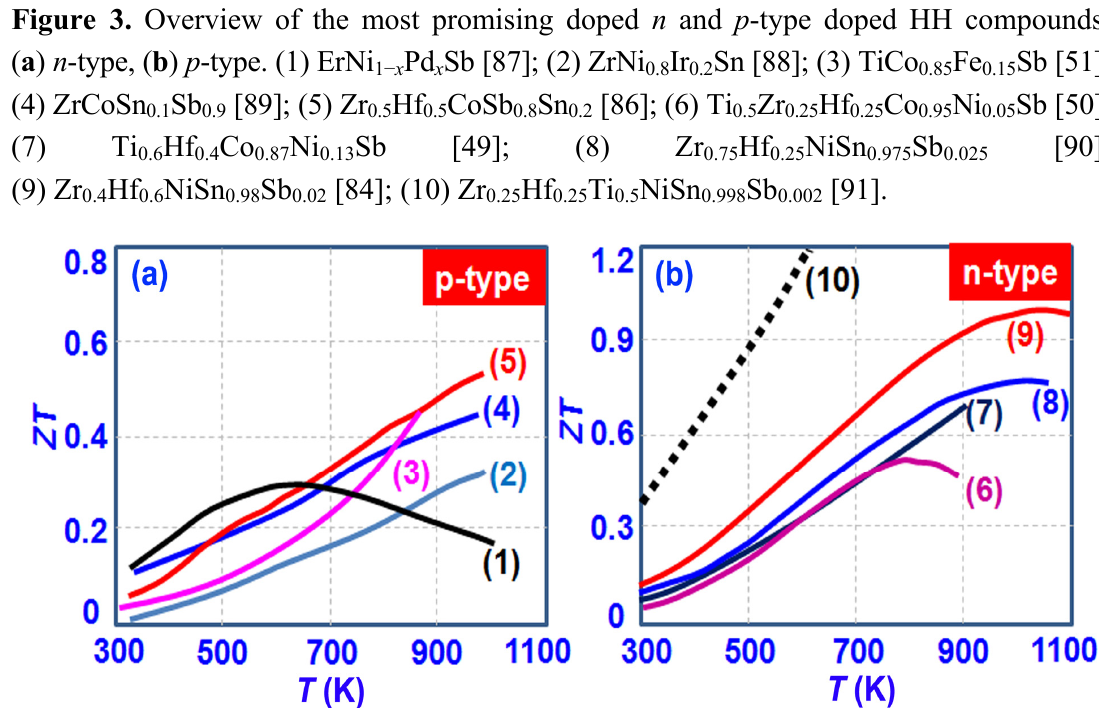
Ir Sn [88]; (3) TiCo 0.8 0.2